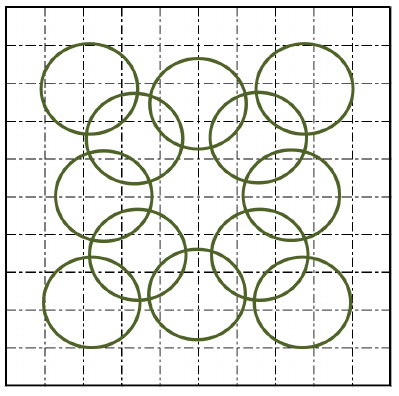
Figure 3. Layout of 5 m × 5 m community-plots. Circles represent spectral footprints taken from outside the plots so as not to trample vegetation. Vegetation surveys were conducted at each 0.5 m interval within a plot for a total of 121 points at the ground, understory, and canopy level.